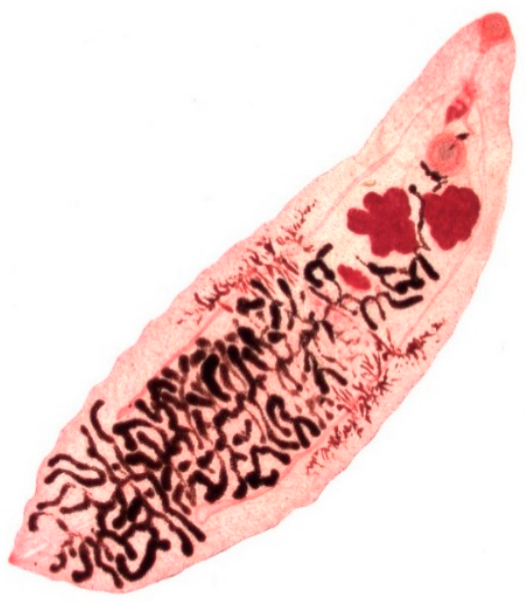
Figure 4. Adult stage of Dicrocoelium dendriticum .